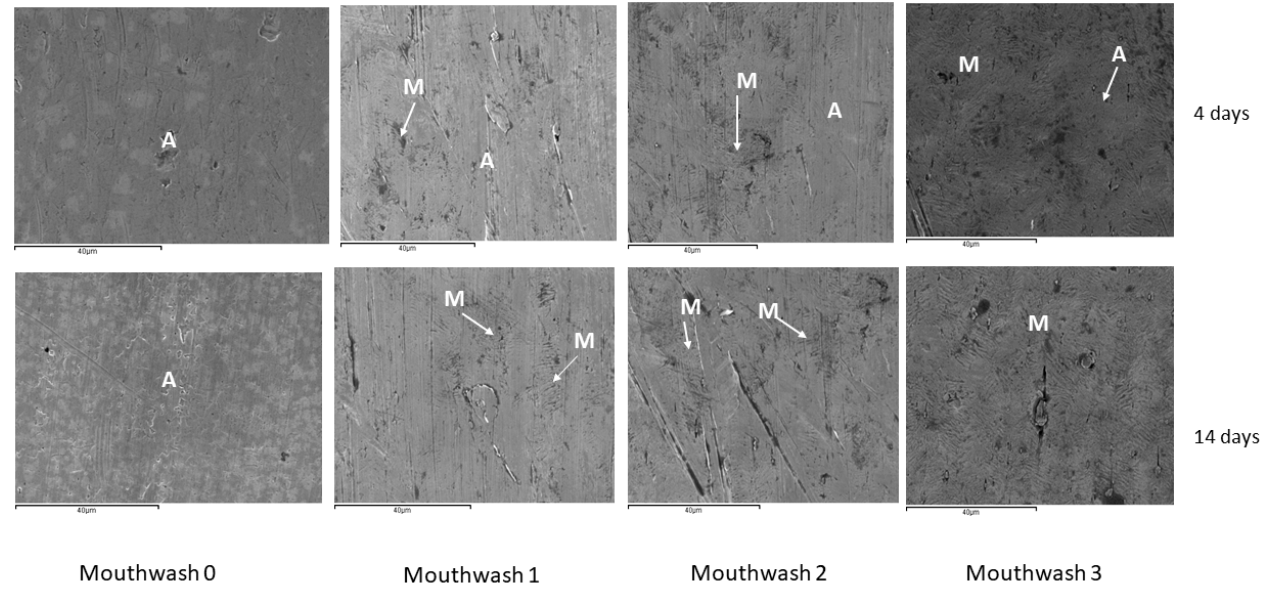
Figure 3. As-received NiTi orthodontic wire. The microstructure is completely austenite.